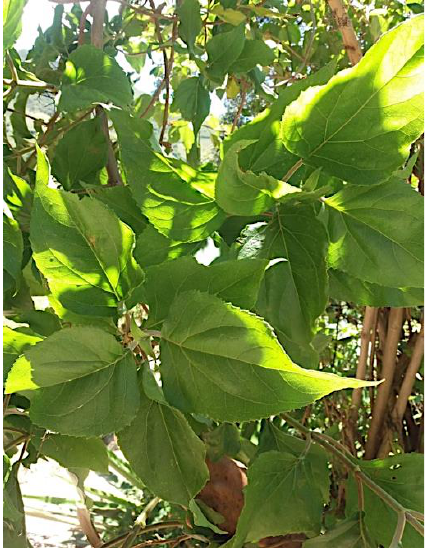
Figure 1. Kaunia longipetiolata (Sch.Bip. ex Rusby) R. M. King and H. Rob. Photo by Cinthia Bravo.